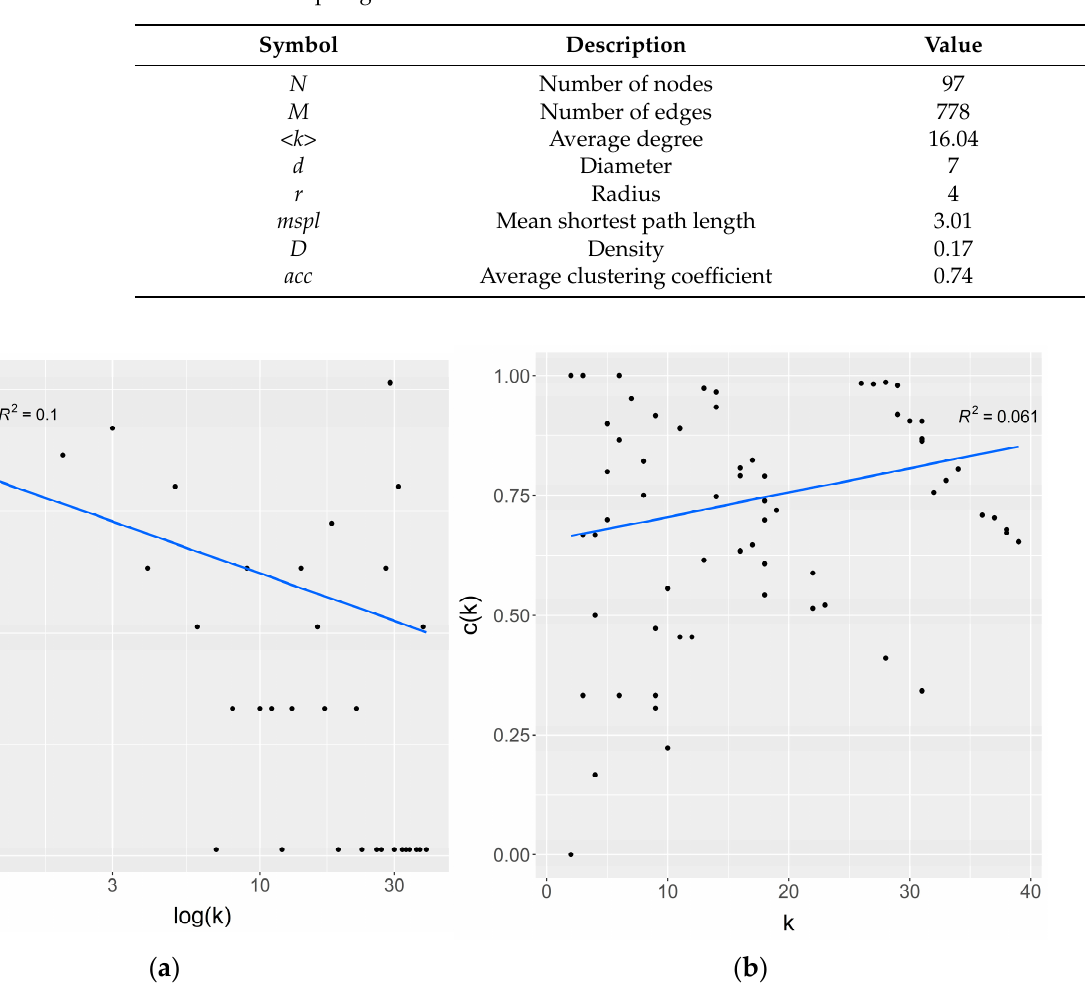
Figure 3. Topological analysis of the IPIN. ( a ) Degree distribution plot. ( b ) Clustering coefficient versus degree plot. k denotes the degree; p( k ) denotes the probability of degree k ; c( k ) denotes the clustering coefficient of a node that has degree k .